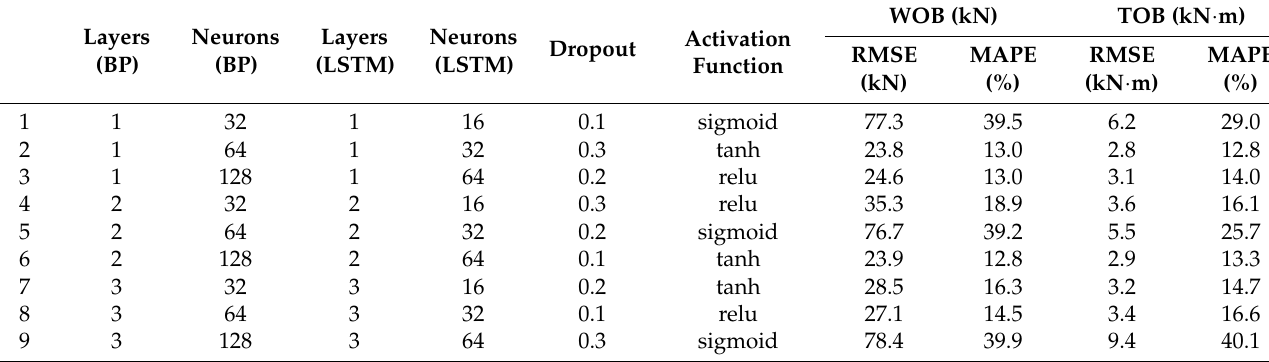
Table 1. Test table of BP-LSTM network